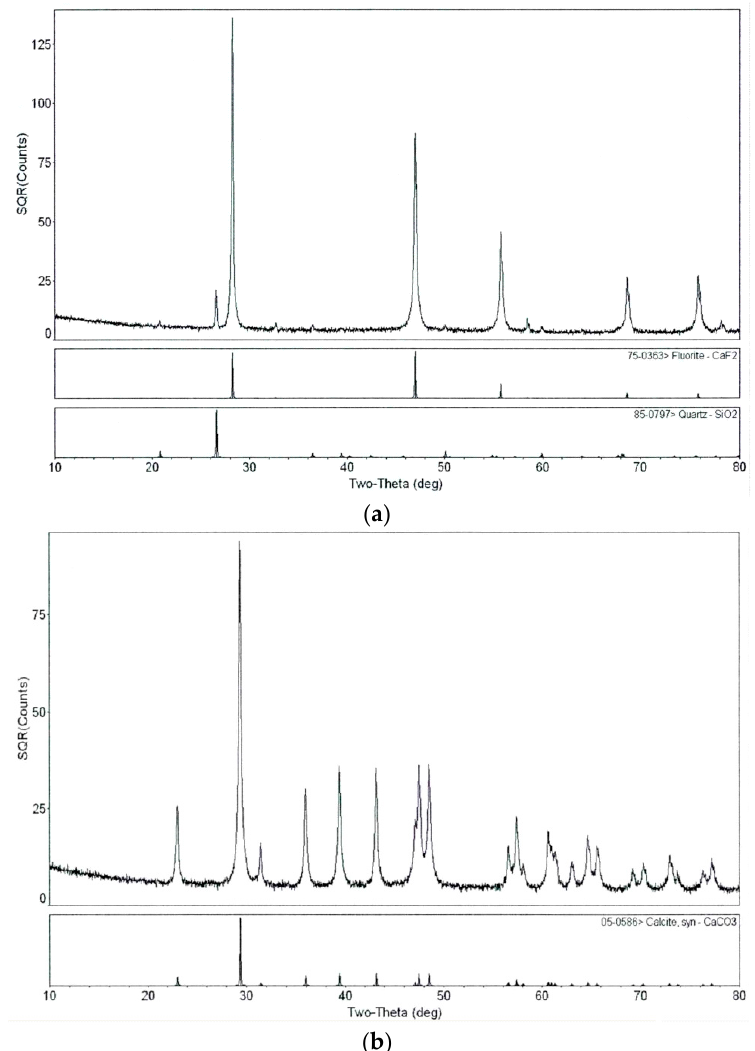
Figure 1. XRD spectrums of powder fluorite ( a ) and calcite ( b ) for flotation tests.